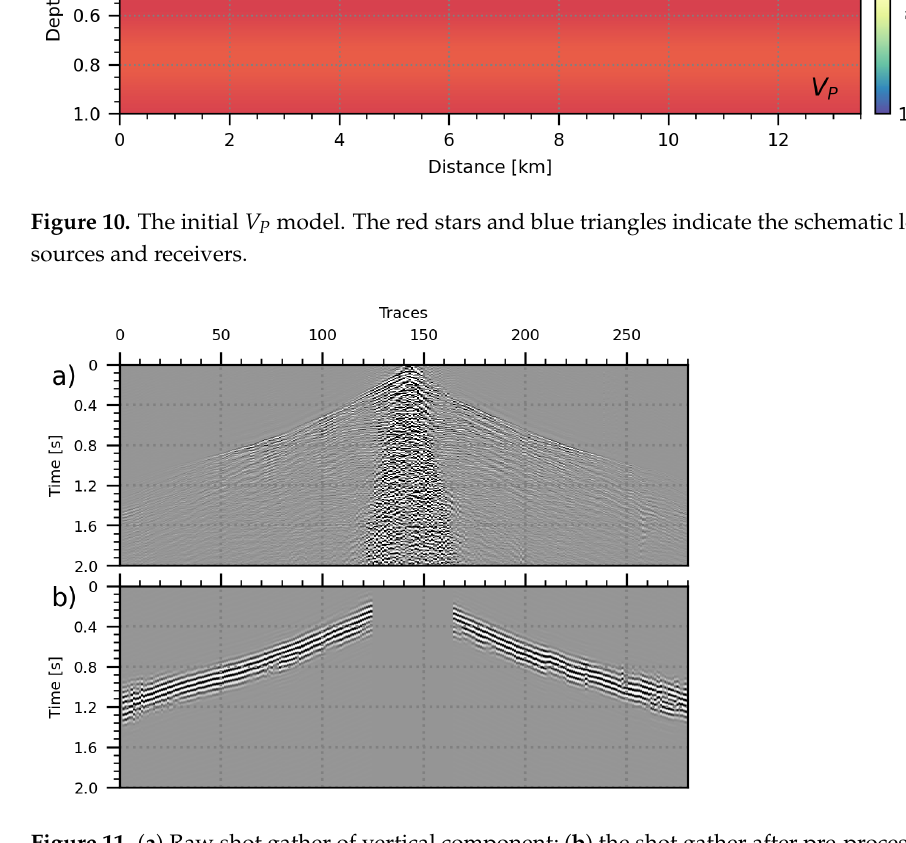
Figure 11. ( a ) Raw shot gather of vertical component; ( b ) the shot gather after